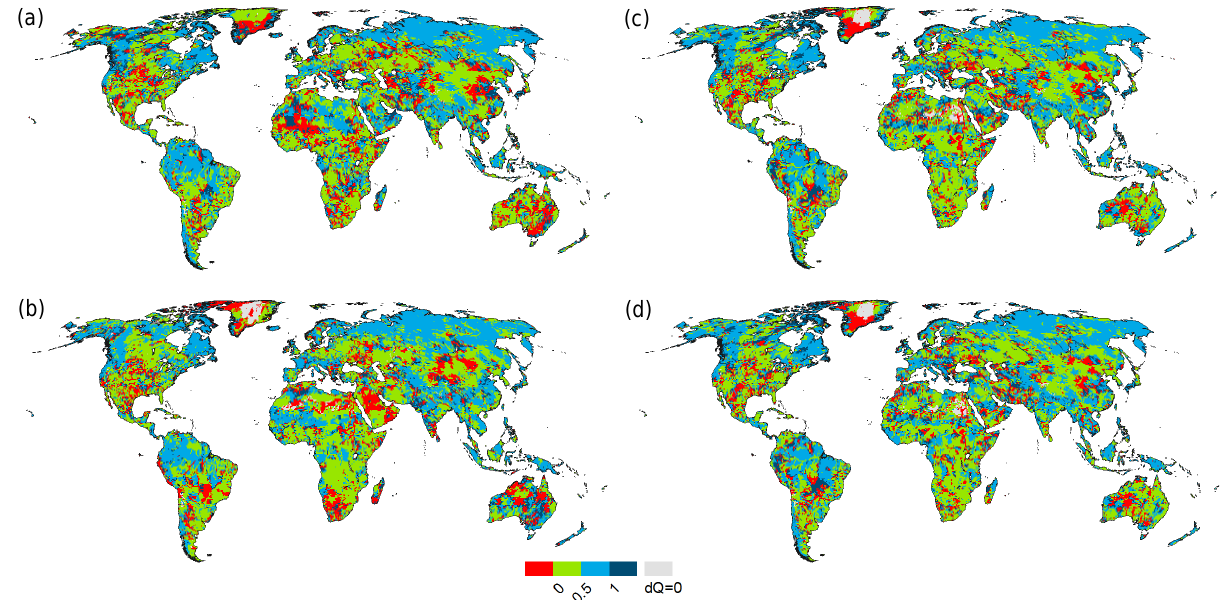
Figure B1. Indicator A n representing dominance of the change of P for the change in Q (Eq. 3) from 1911–1940 to 1941–1970. Grey color indicates that the change in Q is zero, such that A n cannot be computed. Red color indicate areas where A n is negative, i.e., change in P had the opposite sign of the change in Q ; therefore, P was not the dominant driver for change in Q . Results are shown for WaterGAP as driven by the climate forcings GSWP3 (a) , PGFv2.1 (b) , WFDEI_hom (c) , and WFD (d) .